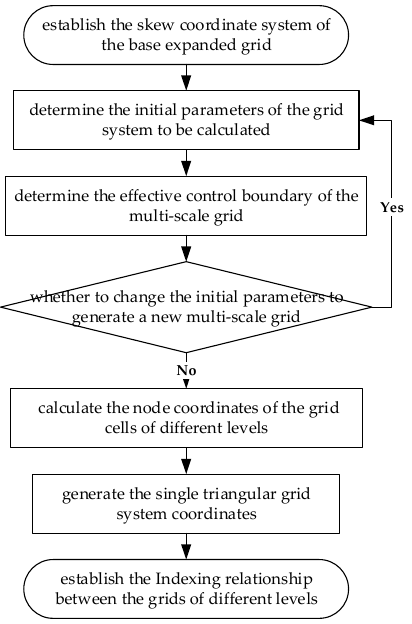
Figure 3. The algorithm flowchart.